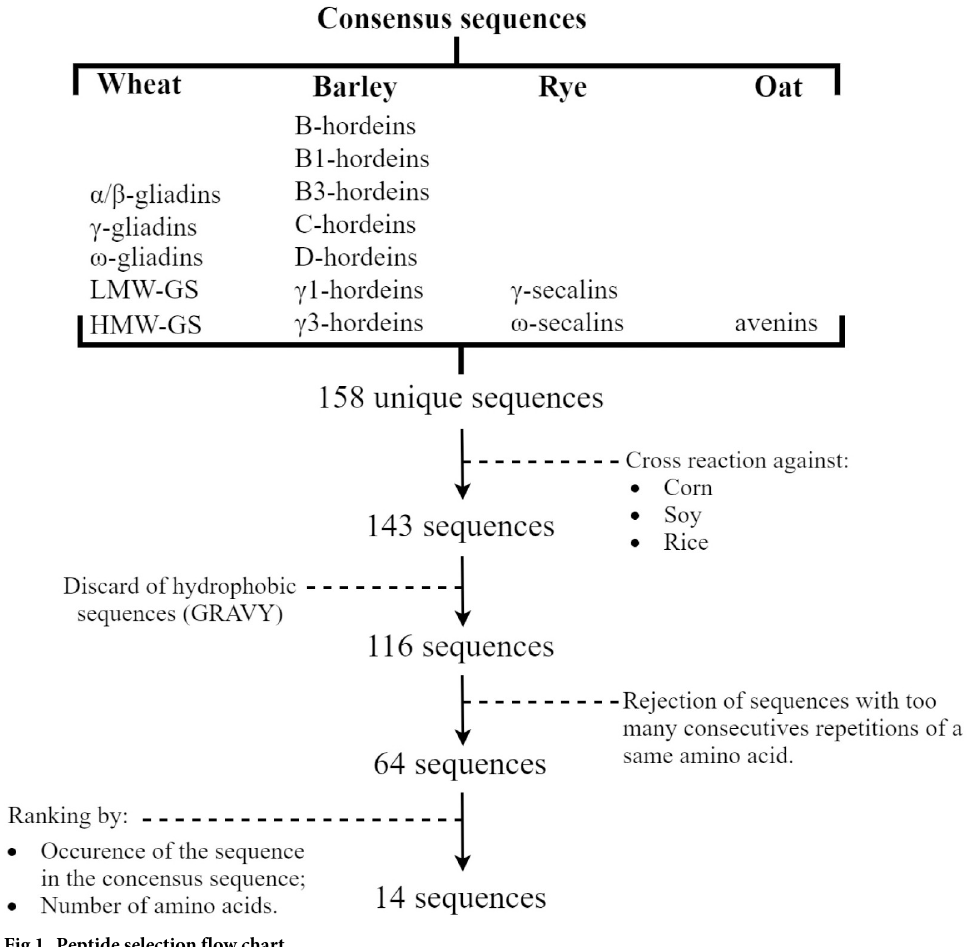
Fig 1. Peptide selection flow